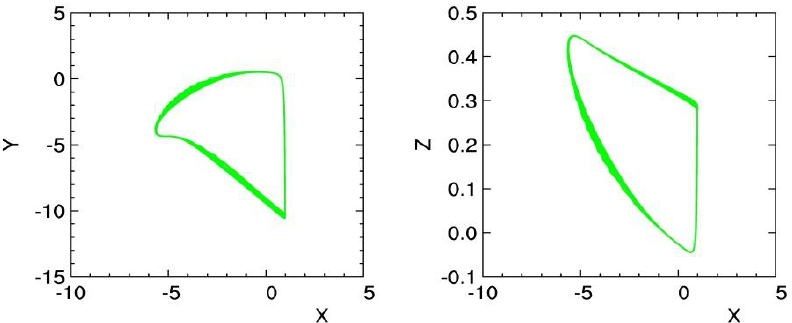
Figure A1. Numerical solution of Equation (A2) with L = 3,000 km. Projections on the ( left ) X – Y and ( right ) X – Z plane in the phase space of the segment of the trajectory extending from τ = 500 to 512.6.